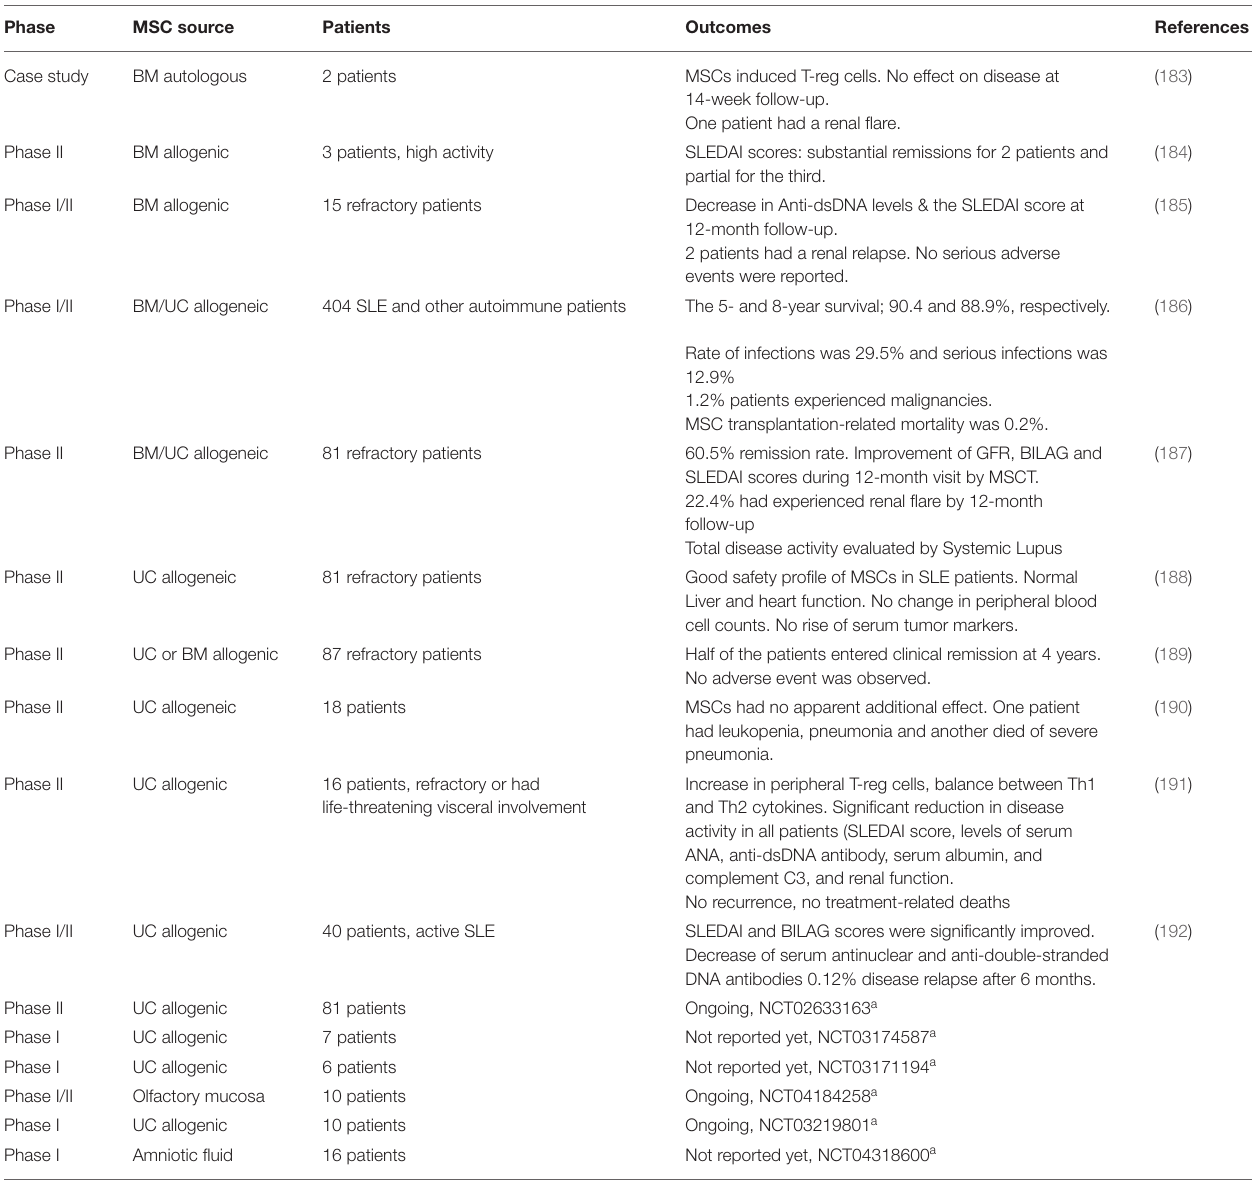
TABLE 2 | Clinical trials for SLE therapy using